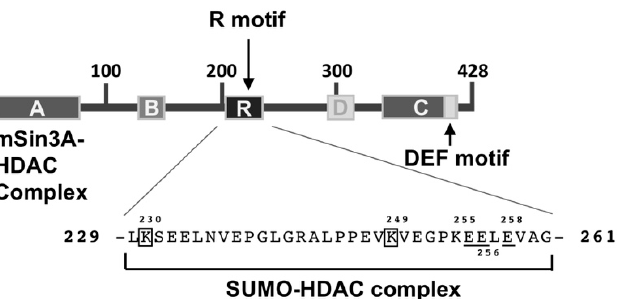
Figure 9. Elk-1 contains two distinct repressor domains. The N-terminal repressor domain recruits the corepressor protein mSin3A, complexed with histone deacetylases, to the N-terminus of Elk-1. The binding of both mSin3A and histone deacetylases is stimulated by the phosphorylation of Elk-1. The R motif represents a repression domain of Elk-1 that functions as a binding site for a SUMO–HDAC-2 complex. SUMO binding requires the lysine residues K230 and K249 (boxes) and a stretch of acidic residues (bars). The sequence information is derived from Ref. [7].